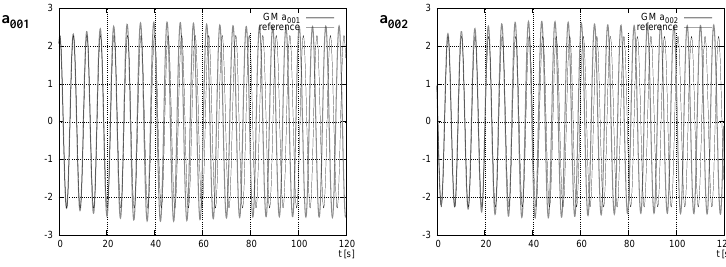
Figure 5. Uncalibrated three-equation Galerkin model: values of Galerkin model’s mode coefficients compared to their reference DNS